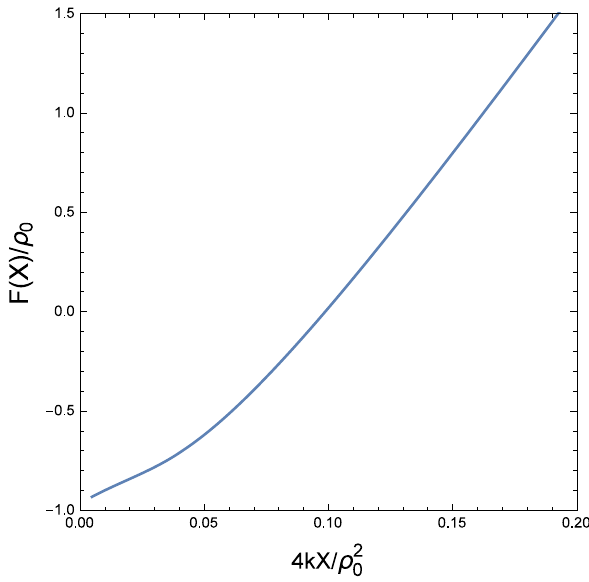
Fig. 2 Here the reconstructed F ( X ) is shown based on the parametrization w 0 + w 1 z with the best fit values of w 0 ,w a obtained from the SNIa data